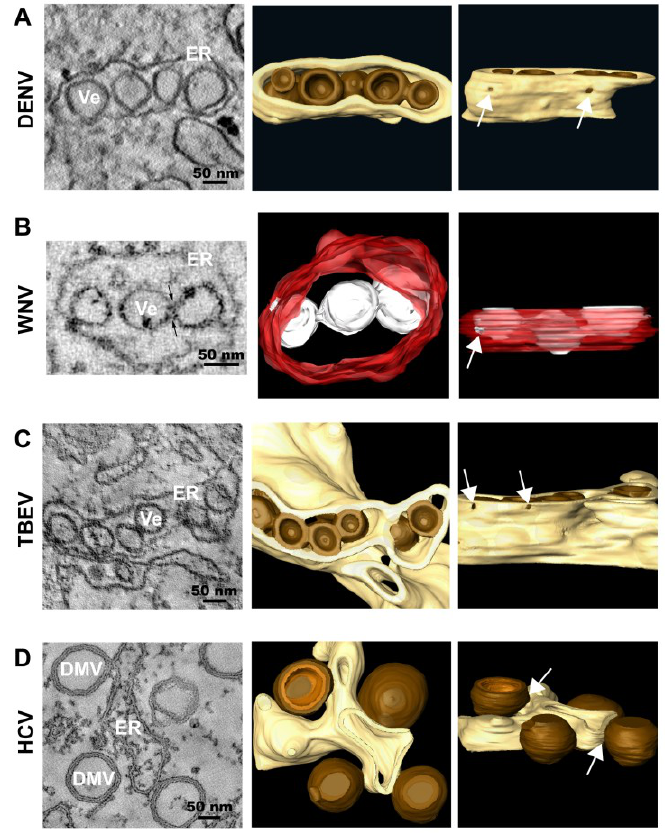
Figure 2. Representative images of membrane rearrangements induced by different members of the family Flaviviridae . ( A ) Dengue Virus (DENV); ( B ) West Nile Virus (WNV); ( C ) Tick-borne Encephalitis Virus (TBEV); ( D ) Hepatitis C Virus (HCV). Slices through tomograms of infected cells ( on the left ) and 3D top and lateral (90° rotation) views of the same tomograms ( on the right ) are depicted, showing the characteristic virus-induced structures. The replication vesicles (Ve) of DENV, WNV and TBEV (genus Flavivirus ) correspond to invaginations of ER membranes that remain connected to the cytosol via 10 nm-pores (highlighted with white arrows in the 3D lateral views), forming vesicle packets (VPs). The replication factory of HCV (genus Hepacivirus ) is primarily composed of double membrane vesicles (DMVs) that seem to be formed asER protusions connected to ER membranes via neck-like structures (highlighted with white arrows in the 3D lateral view). The ER is shown in yellow (DENV, TBEV and HCV) or in red (WNV) and the replication organelles in brown (DENV, TBEV and HCV) or in white (WNV). The outer and inner membranes of DMVs are depicted in different shades of brown (outer membrane in dark brown and inner membrane in light brown). Figure 2B is reproduced with permission from